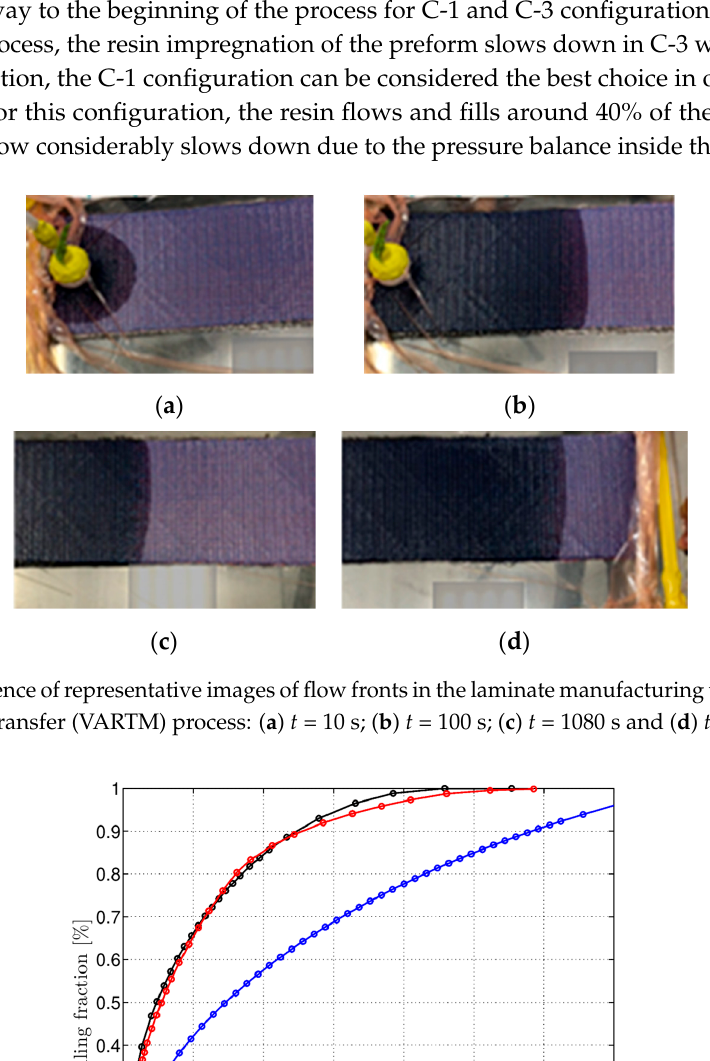
Figure 8. Sequence of representative images of flow fronts in the laminate manufacturing under vacuum assisted resin transfer (VARTM) process: ( a ) t = 10 s; ( b ) t = 100 s; ( c ) t = 1080 s and ( d ) t = 2055 s.